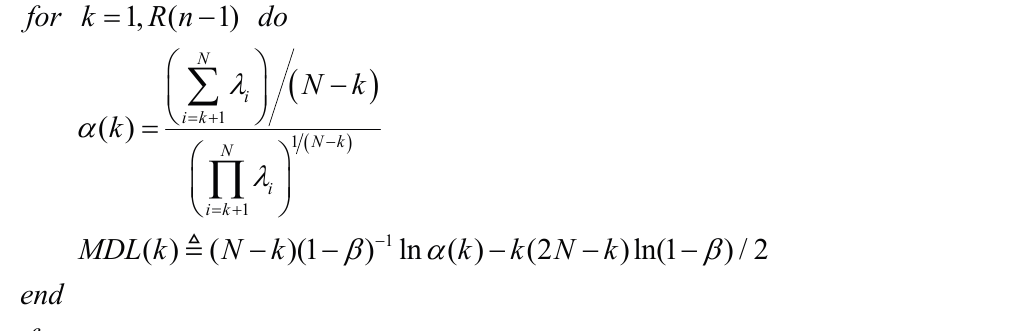
Algorithm 3. Minimum description length (MDL) criterion.